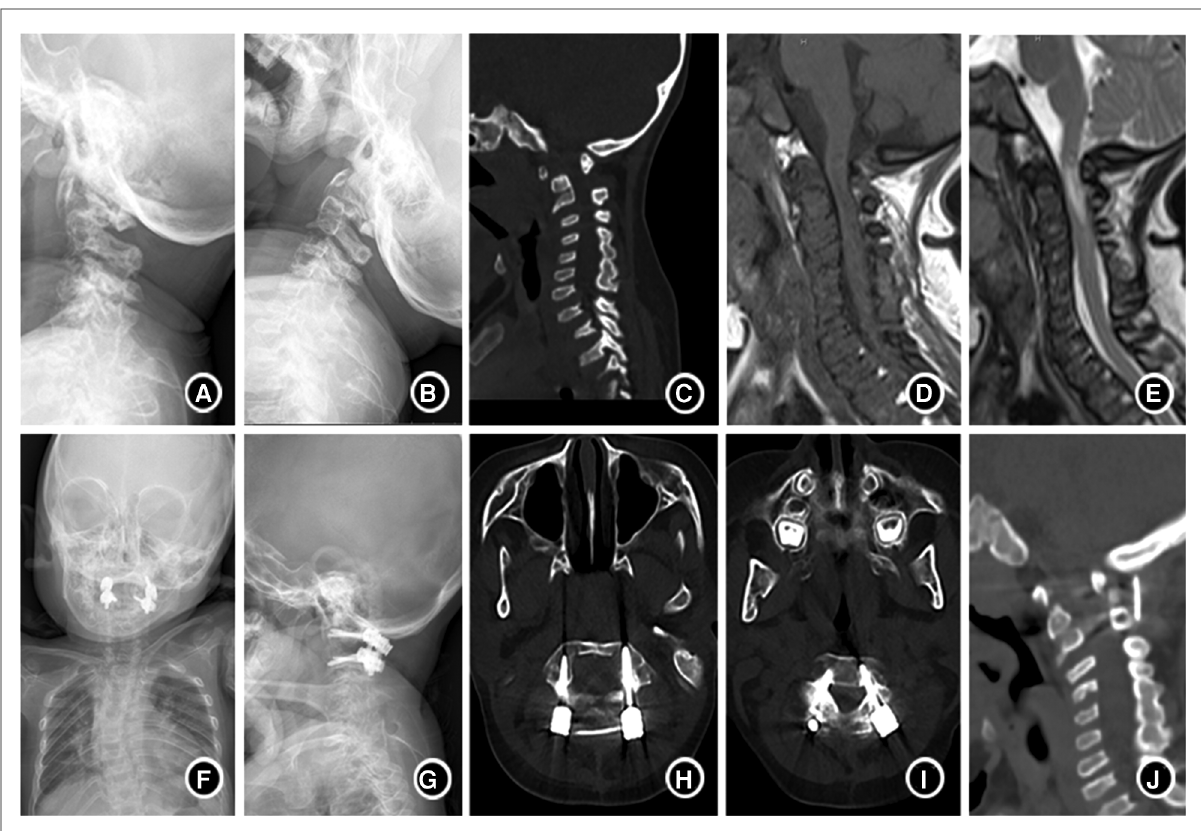
FIGURE 3 A 4-year-old boy with type IVA mucopolysaccharide disease ( A,B ). Lateral plain- fi lm fl exion-extension studies before the surgery showed uneven cervical bone density, fl attened vertebra, atlantoaxial instability. ( C ) CT suggested atlantoaxial subluxation and odontoid process absence; ( D,E ) MRI indicated spinal canal stenosis, high cervical spinal cord compression and edema; ( F,G ) showed that the anatomical position of atlantoaxial returned to normal half a year after operation. ( H – J ). CT showed that the screw position was good, and the bone graft was fused with the atlantoaxial vertebra 6 months after